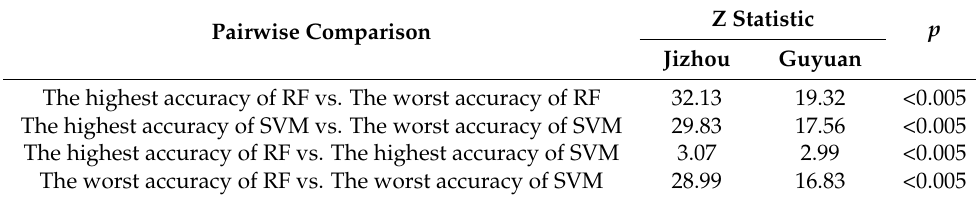
Table 6. Z test values for the pairwise comparison of the error matrices for mapping PMF in Jizhou and Guyuan.